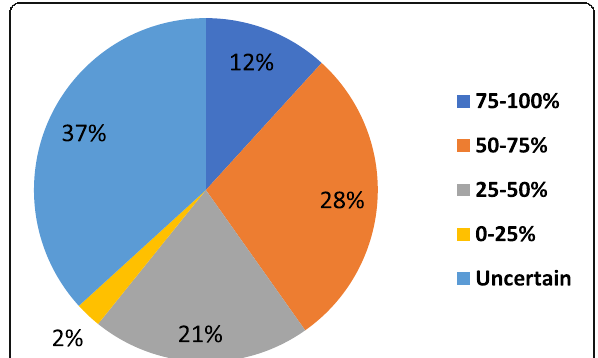
Fig. 4 Responses to question 10: Expected percentage of pain relief (reported as ranges) from medical marijuana among those willing to consider it ( n =